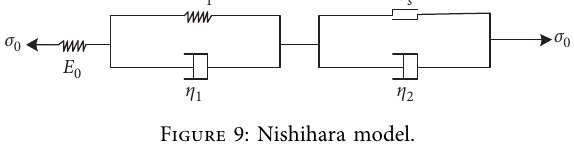
Figure 9: Nishihara